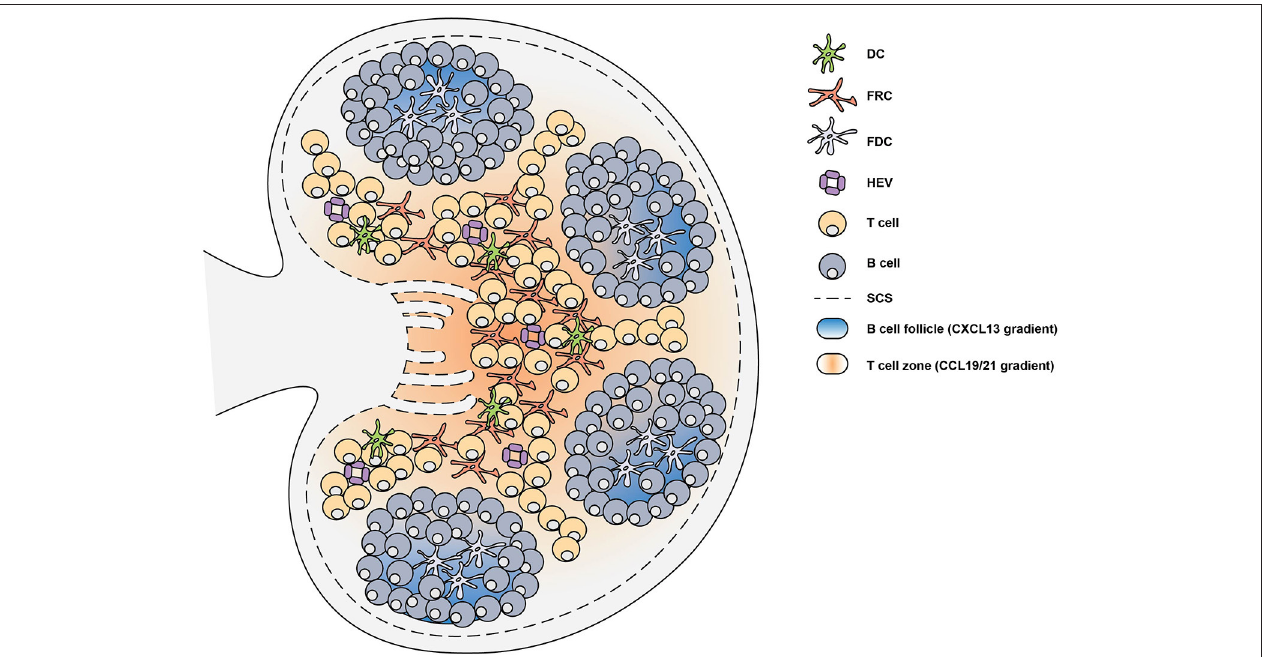
FIGURE 2 | Lymph node structure is supported by stromal cells. Secondary lymphoid organs are divided into distinct regions through the generation of chemokine gradients by stromal cells. In the lymph node (LN), these chemokine gradients allow the circulation of lymphocytes which enter through high endothelial venules (HEV). In the T cell zone, fibroblastic reticular cells (FRCs) generate a CCL19 and CCL21 gradient which facilitates the migration of T cells and dendritic cells (DCs). The B cell follicles contain follicular dendritic cells (FDCs) which generate a CXCL13 gradient that promote the localization of B cells. Upon infection or immunization, antigen can enter the LN through the subcapsular sinus (SCS) or can be brought by DCs to trigger the activation of